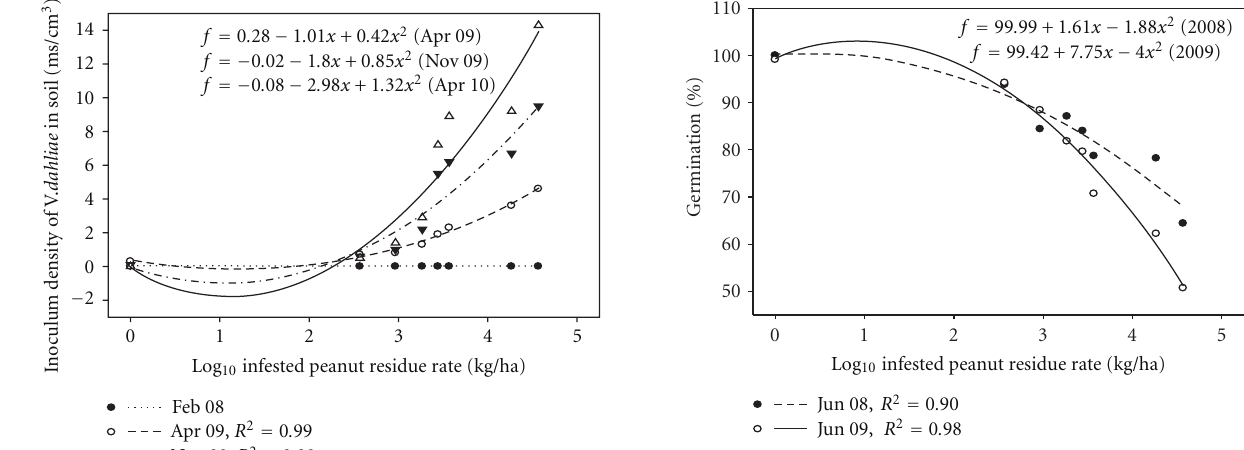
Figure 2: E ff ect of infested peanut residue rates on germination of cotton seeds (%). Infested peanut residue rates 0, 370, 925, 1850, 2775, 3700, 18495, and 37000 kg/ha were log 10 transformed and were expressed as 0, 2.6, 3.0, 3.3, 3.4, 3.6, 4.3, and 4.6 on X -axis. Linear quadratic equation f = y 0 + ax + bx 2 was used to calculate intercept ( y 0 ), slope (a) and curvature (b).